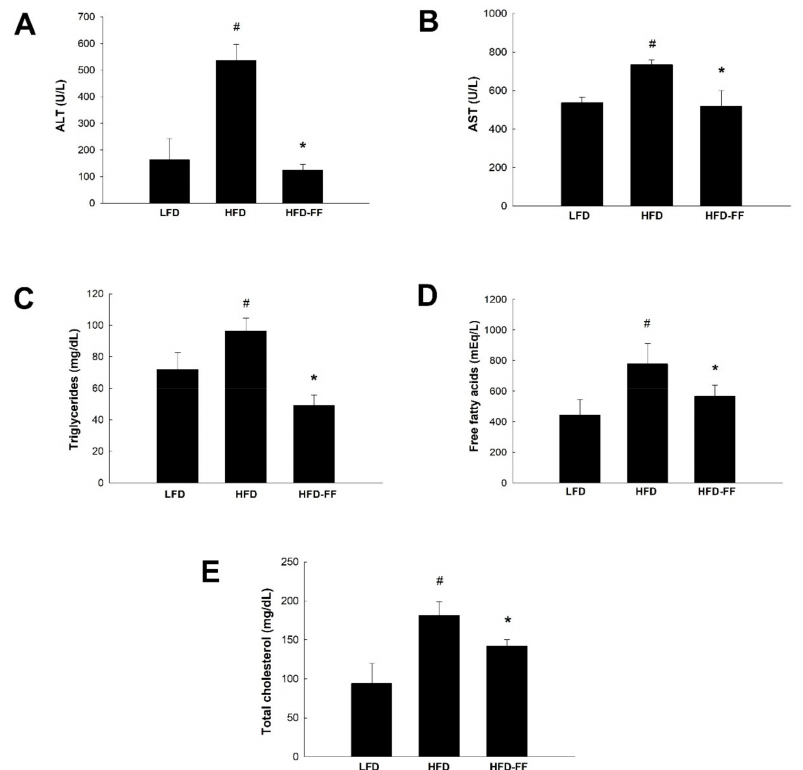
Figure 2. Effects of fenofibrate on circulating ALT, AST and lipid levels in HFD-fed female OVX mice. OVX C57BL/6J mice were fed an LFD, an HFD or an HFD supplemented with fenofibrate (HFD-FF, 0.05% w / w ) for 21 weeks. Plasma levels of ( A ) ALT and ( B ) AST. Plasma levels of ( C ) triglycerides, ( D ) free fatty acids, and ( E ) total cholesterol. All values are expressed as the mean ± SD ( n = 8/group). # p < 0.05 compared with LFD. * p < 0.05 compared with HFD.